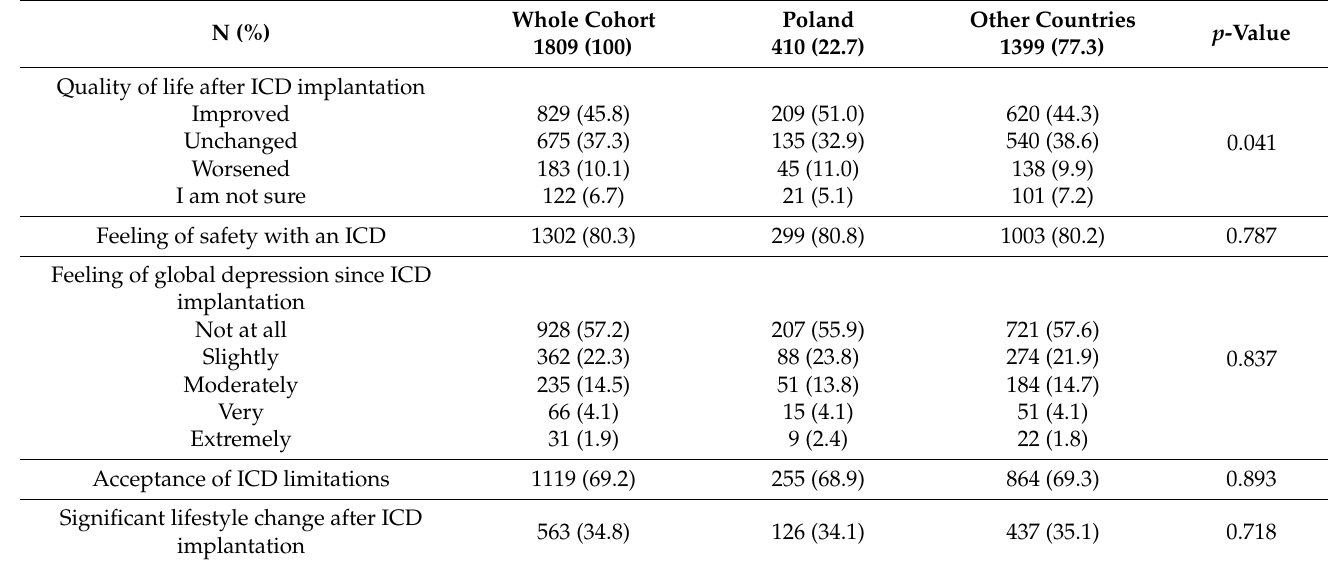
Table 2. Quality of life aspects according to cohorts.